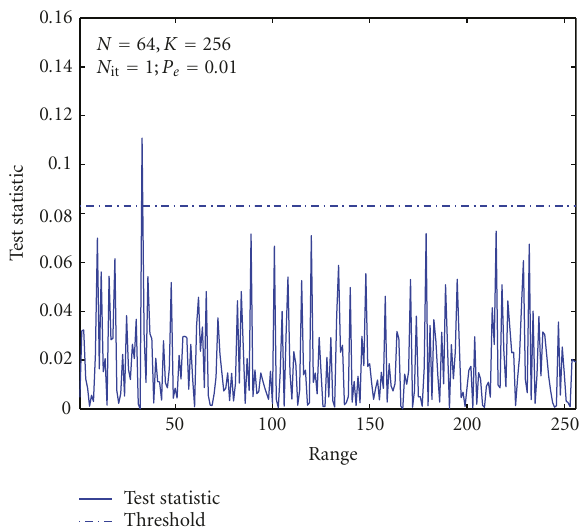
Figure 2: Test statistic versus range in K -distributed homogeneous clutter, where ν = 0 . 5, μ = 1, N = 8, K = 32, N it = 1, and P e = 0 . 025.